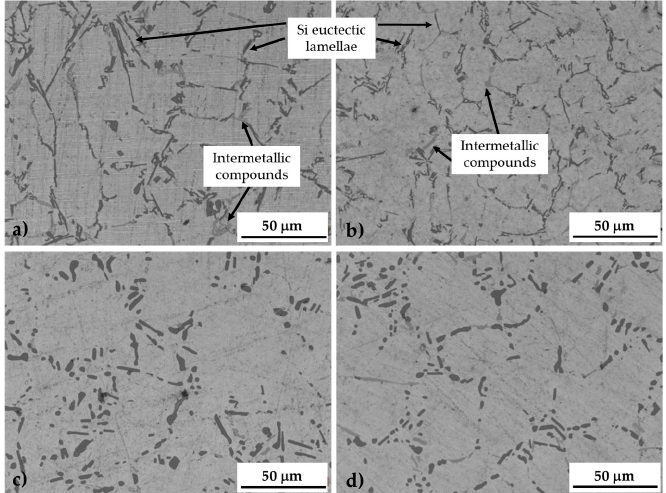
Figure 4. Microstructure of as-cast NUST ( a ) and UST ( b ) samples and heat treated T6 NUST ( c ) and UST ( d ) samples.